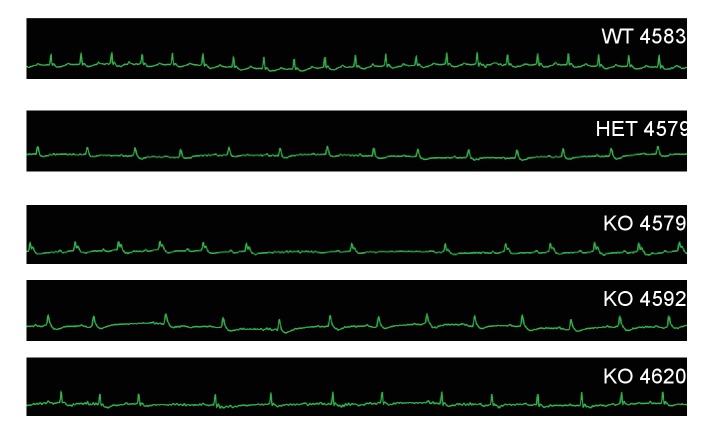
Mc4r−/− animals display bradycardic arrhythmias.Rhythm strips of 30 week old WT, Mc4r-/+ and Mc4r−/− animals taken during echocardiograms. Mc4r−/− mice display sinus bradycardia with abnormal rhythmicity.